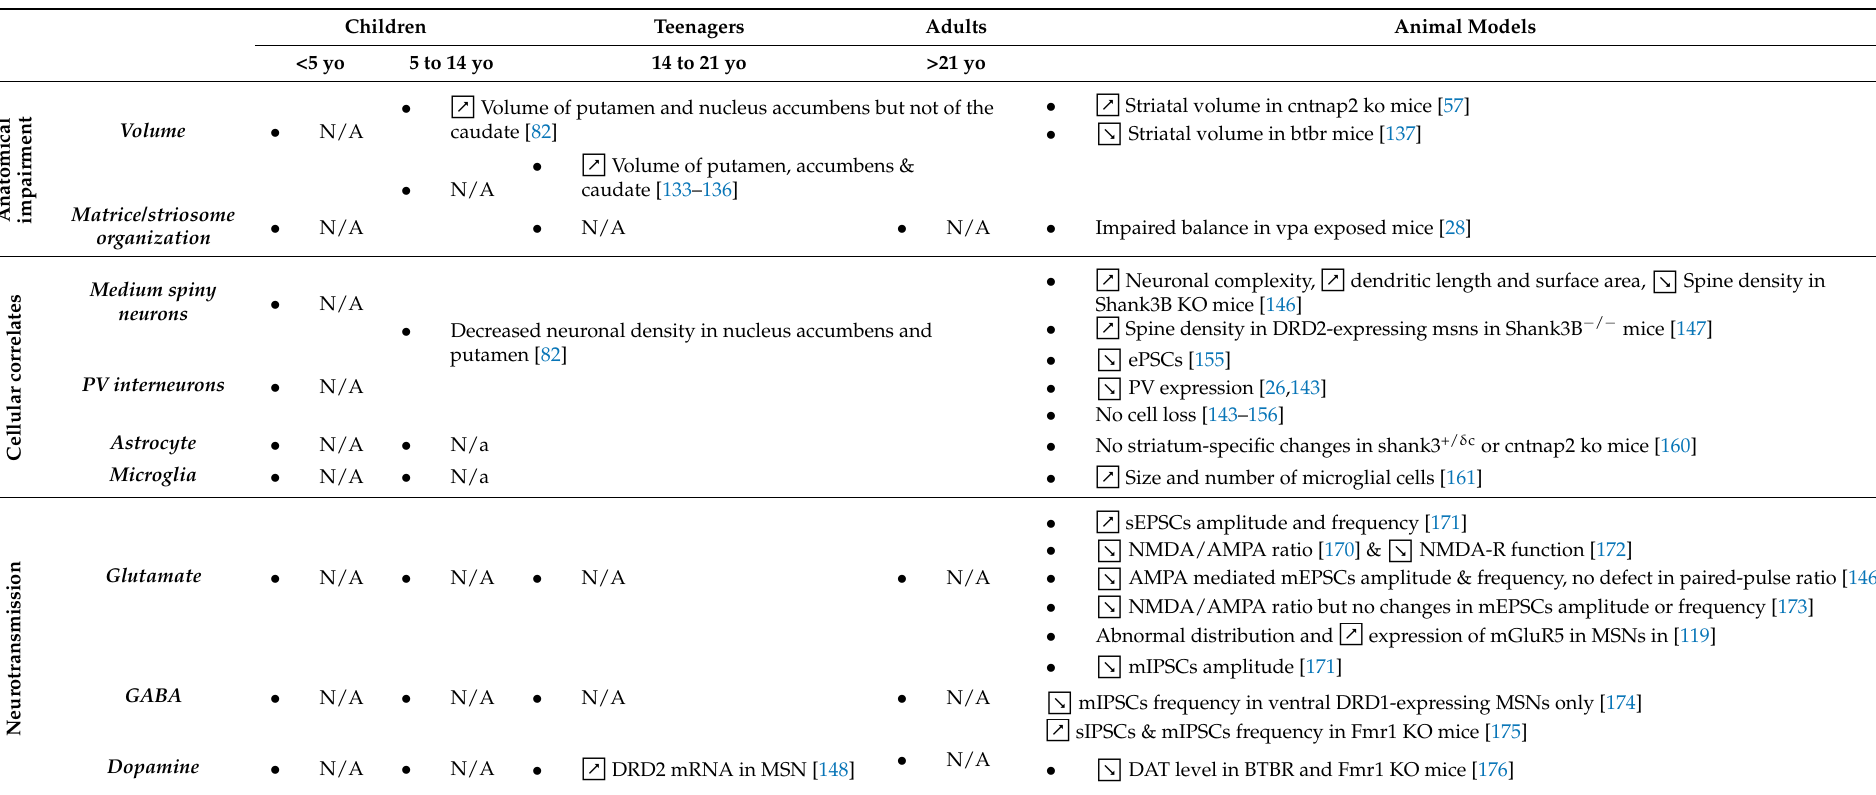
Table 1. Various outcomes in various animal models of valproic acid administration during development in relation with species, dose and age. This table reca- pitulates the different VPA models and their phenotypes. IP: Intraperitoneal injection, USV: Ultrasonic vocalizations, D1R and D2R: D1 dopamine receptor and D2 dopamine receptor, PC: Purkinje cells, MOR: Mu opioid receptor, PV: Parvalbumin interneurons, mPFC: median Prefrontal cortex, GABAP3: GABA receptor subunit p3.